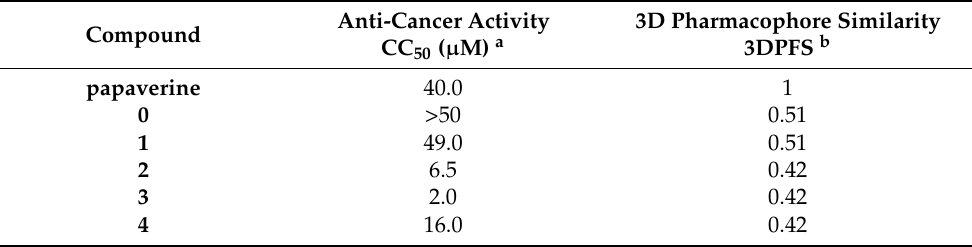
Table 1. Anti-cancer activities of five 6M3SC derivatives and their 3D pharmacophore similarities against